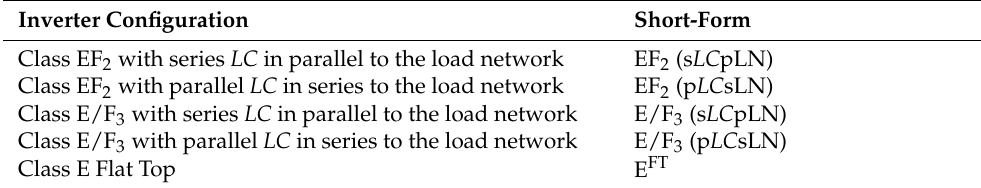
Table 1. Inverter